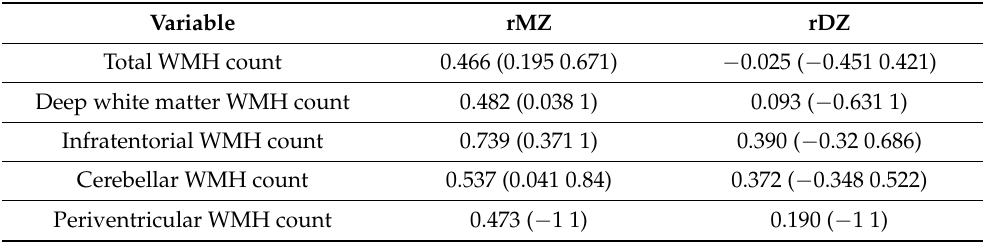
Table 2. Intra-pair correlation coefficients of WMH count in the different brain regions in MZ and DZ twins. Results and 95% confidence intervals were reported (95% CI). rMZ: intra-pair correlation coefficient in monozygotic twins, rDZ: intra-pair correlation coefficient in dizygotic twins. Variable rMZ rDZ Total WMH count 0.466 (0.195 0.671) − 0.025 ( − 0.451 0.421) Deep white matter WMH